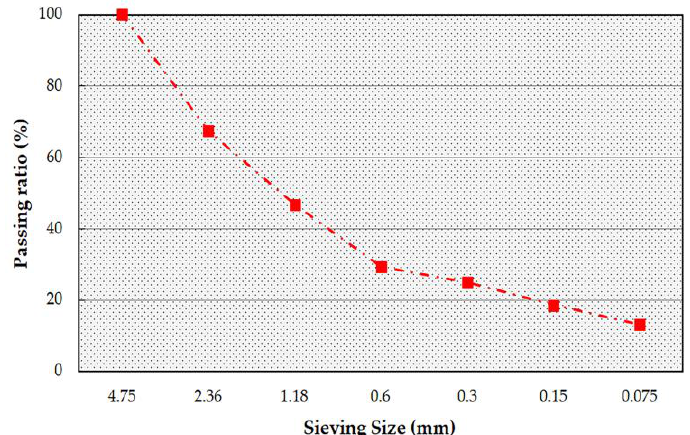
Figure 2. Gradation of asphalt mastic.